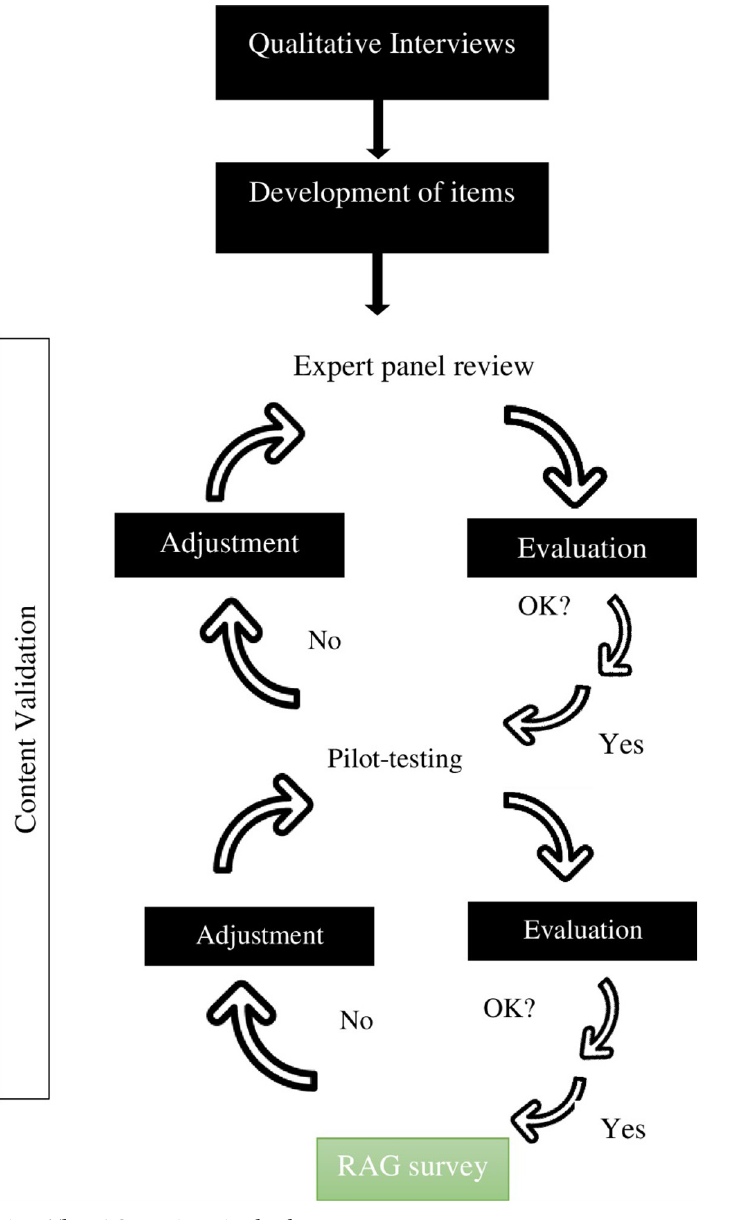
Fig 2. The RAG questionnaire development